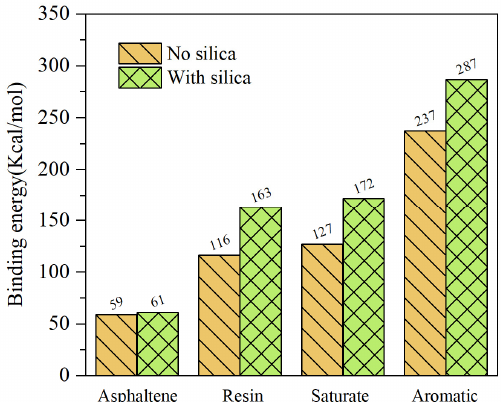
Figure 15. Binding energies among SARA components of virgin asphalt with aged asphalt (without silica) and RAM (with silica).